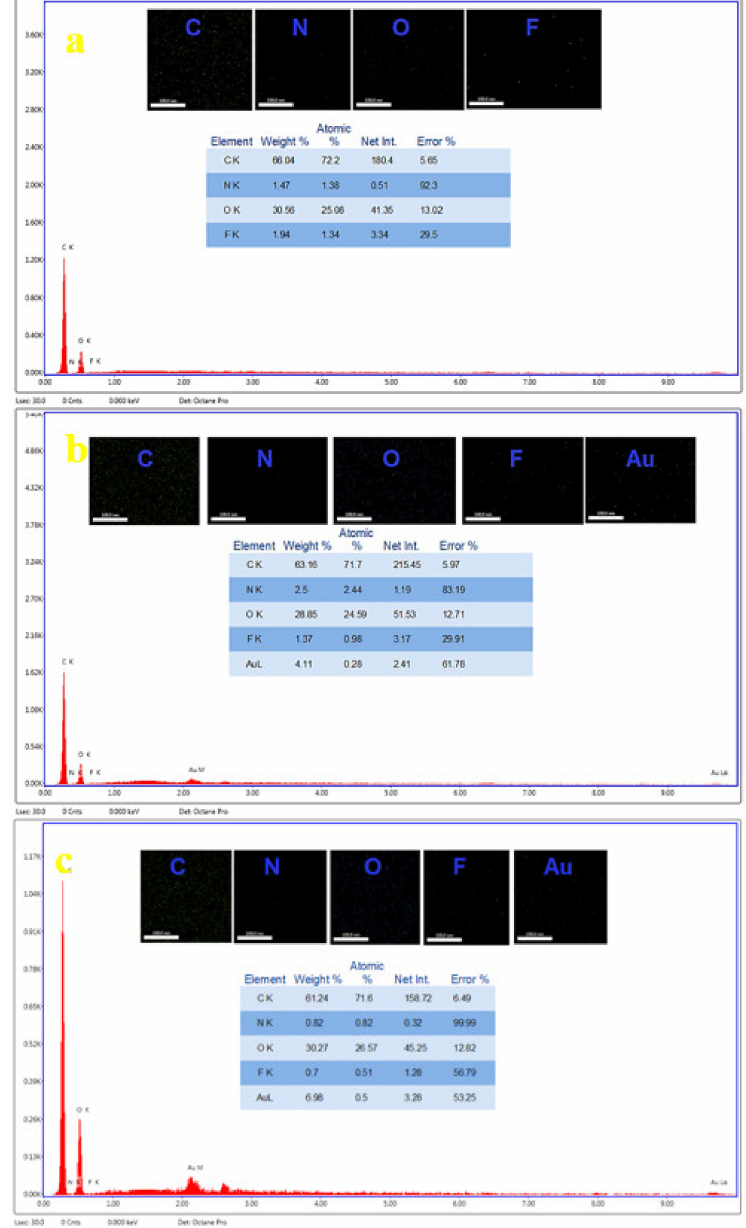
Figure 3. Energy-dispersive X-ray spectroscopy (EDX) and mapping area for ( a ) NF2, ( b ) NF4, and ( c ) NF6 (selected formulations based on Mox